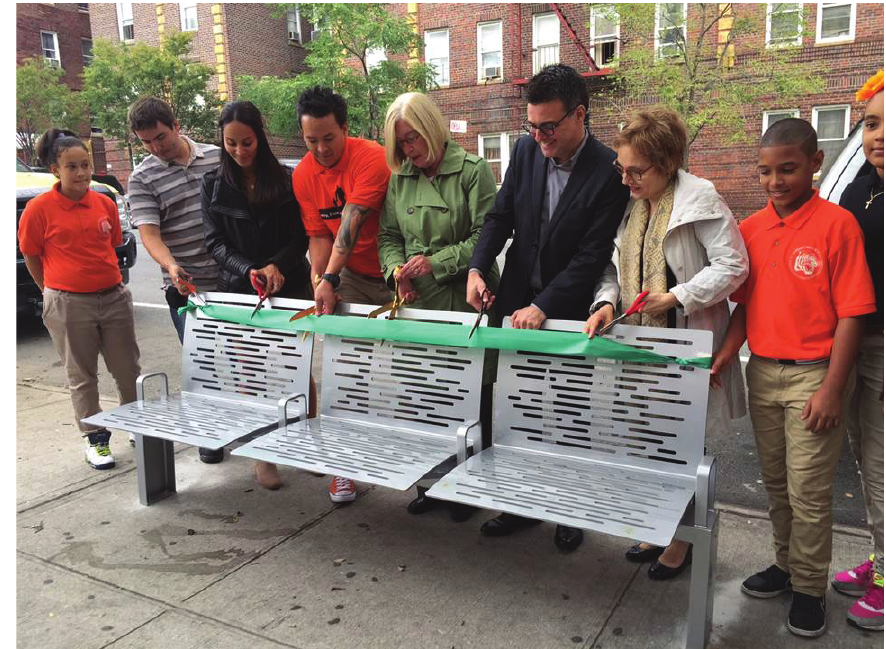
Figure A3. CityBench Program inauguration in New York. Source: Sayer